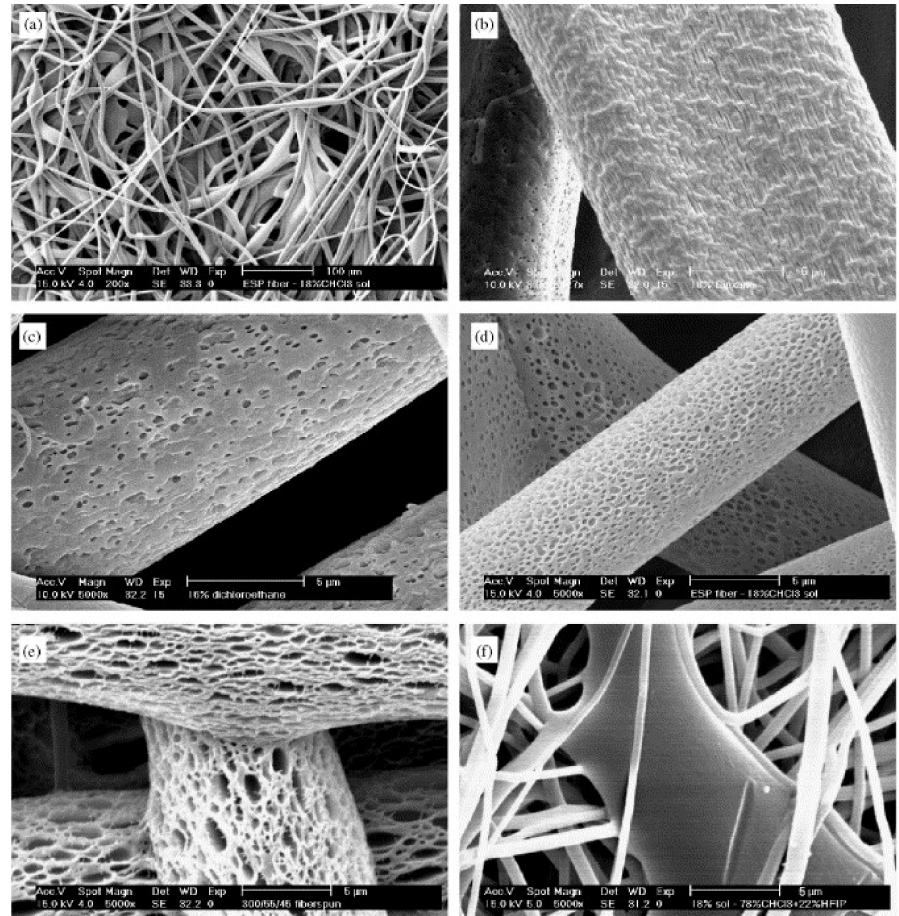
Figure 5. SEM pictures of an E-spun PEOT / PBT sca ff old with di ff erent fiber pore morphology: ( a ) low magnification global view of the sca ff old (scale bar: 100 µ m), ( b ) dioxane as the solvent, ( c ) dichloroethane used, ( d ) chloroform, ( e ) dichloromethane, and ( f ) a mixture of chloroform and HFIP used. Scale bar: 5 µ m. Reprinted with permission from [56]. Copyright © 2020 Elsevier